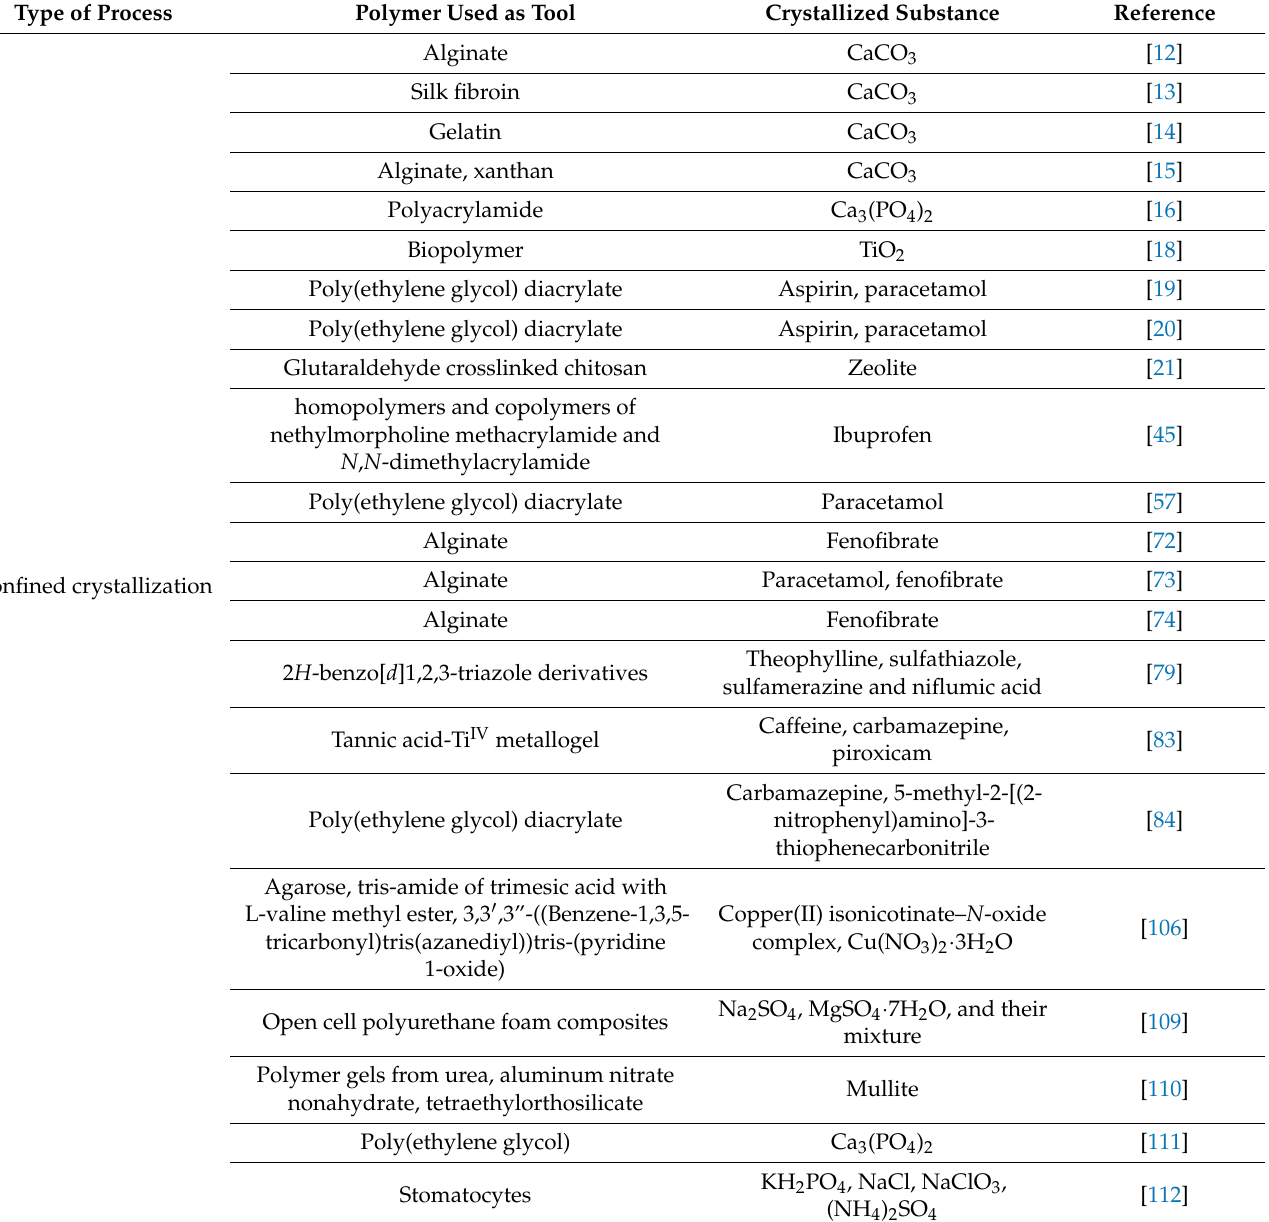
Table 1. Confined crystallization: Polymers and crystallized substances. Type of